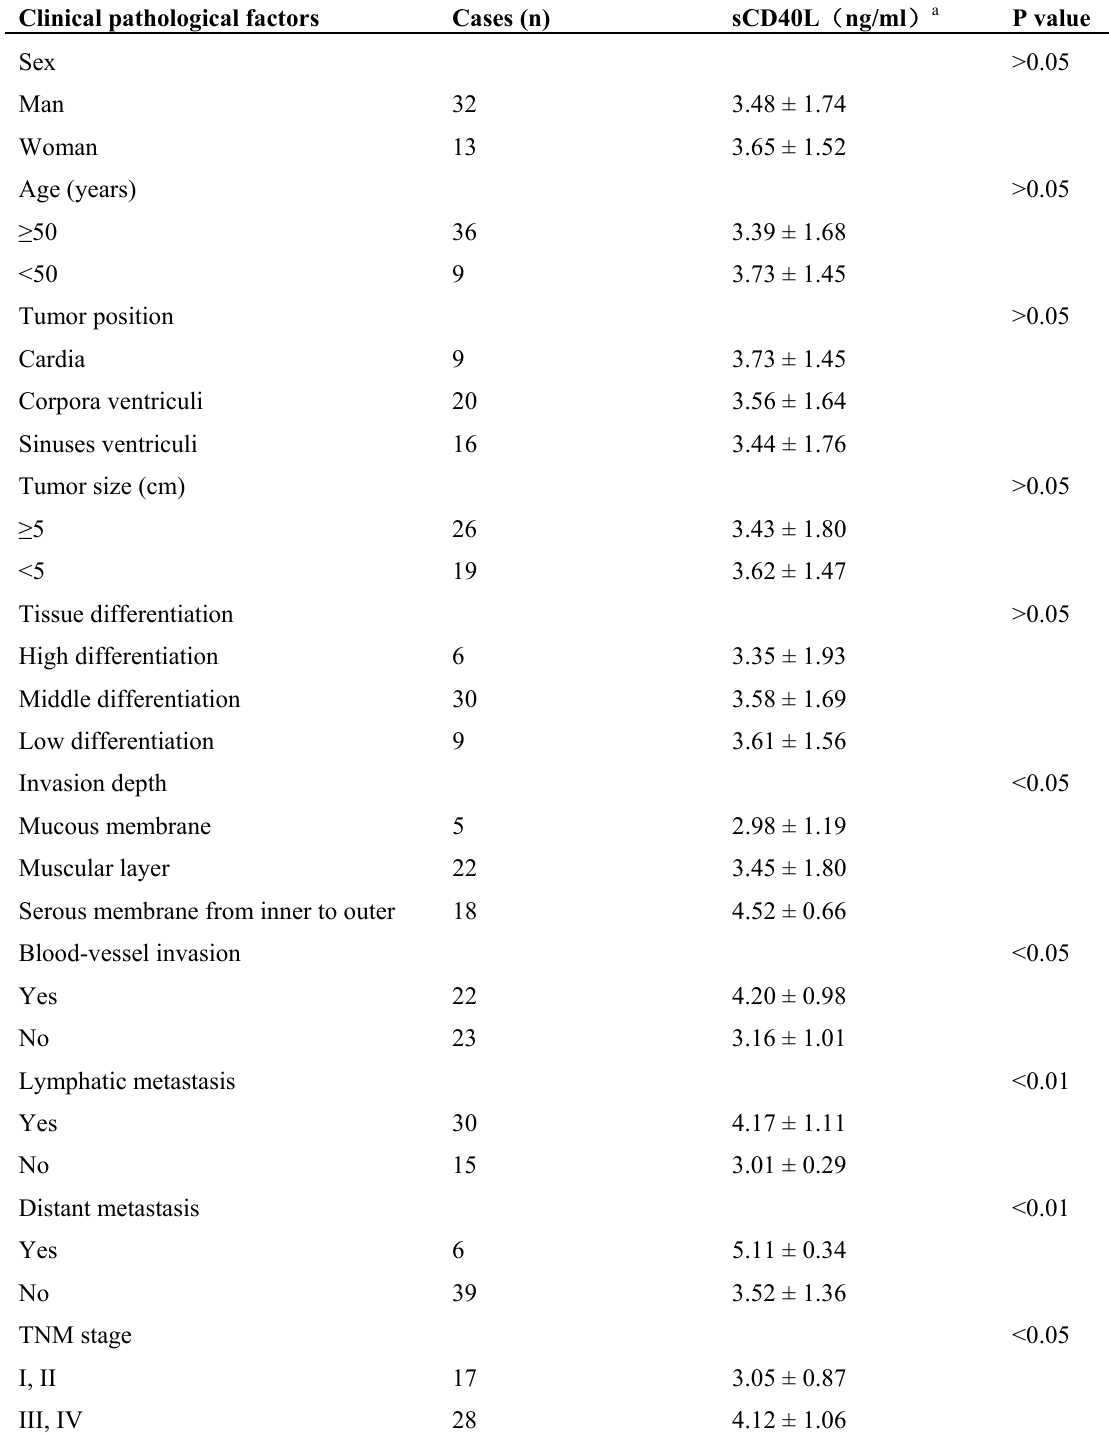
Table 6. Univariate analysis of relationship of serum sCD40L level with clinical pathological factors in patients with gastric cancer, a Values are mean ±